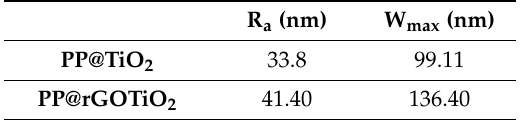
Figure 6. 3D images of PP@TiO 2 ( a ) and PP@rGO-TiO 2 ( b ) photocatalysts. Table 1. R a and W max values for PP@TiO 2 and PP@rGO-TiO 2 photocatalysts.